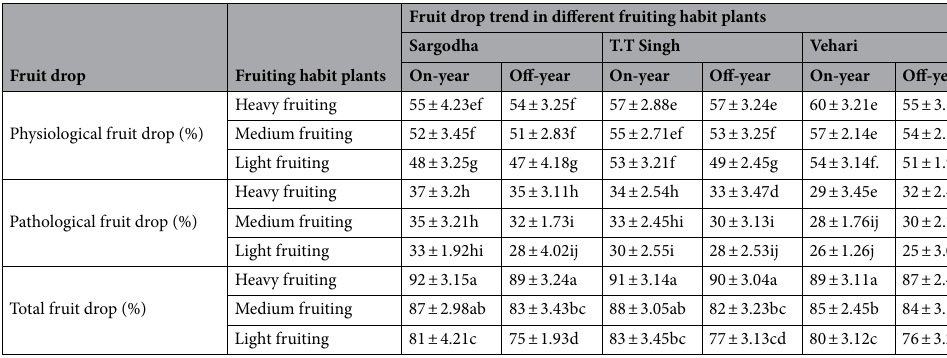
Total fruit drop